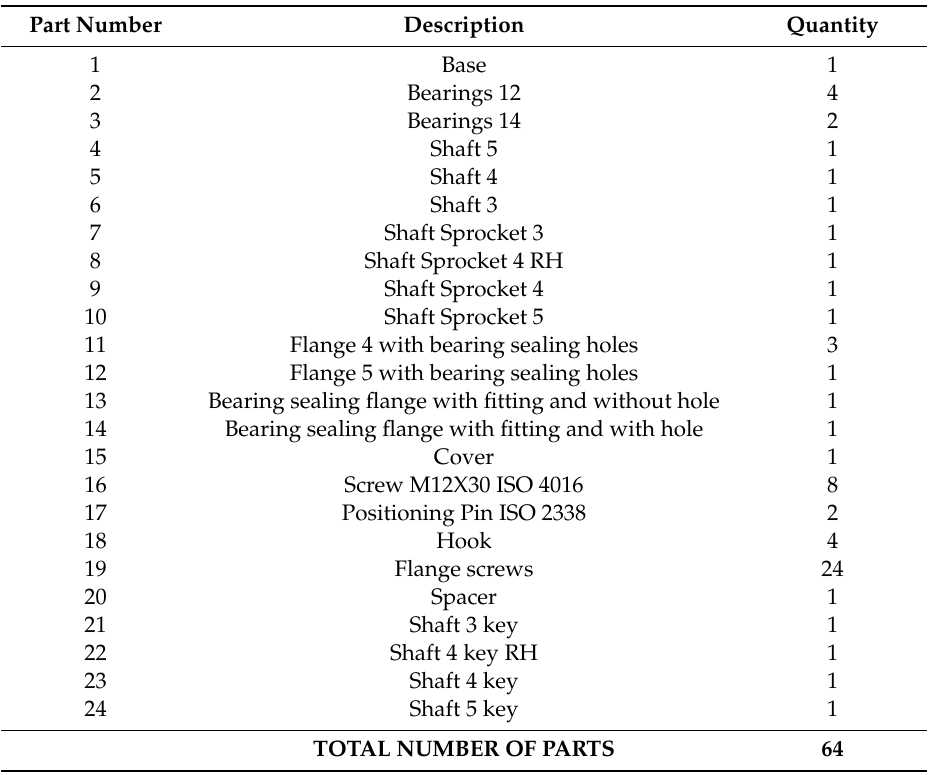
Table 1. Bill of materials (BOM).